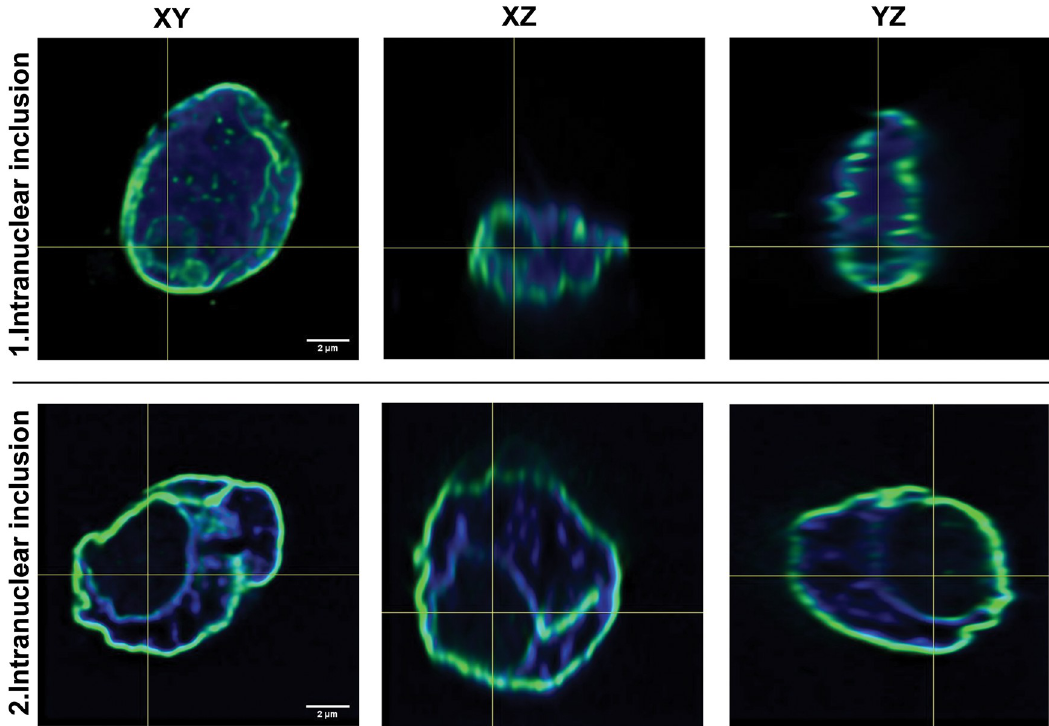
Fig 3. 3D nuclear imaging with lamin AC immunofluorescence in X-, Y- and Z-axis. For the first intranuclear inclusion 197 optical sections of 0.1 μ m were imaged and 137 of them were used for 3D reconstruction. The second intranuclear inclusion was reconstructed from 124 of 191 optical sections (0.1 μ m). Images reveal two representative tumor cell nuclei of a thyroid carcinoma patient. Both the nuclear membrane and the limiting membrane of the inclusion show lamin AC immunoreactivity (green staining), however that of the second inclusion is weaker. DNA staining was performed with DAPI (blue), which is lacking within the NI. The images demonstrate NI that are in all three planes completely closed and delimited by the nuclear